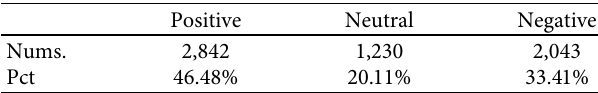
Table 2: Financial dictionary.